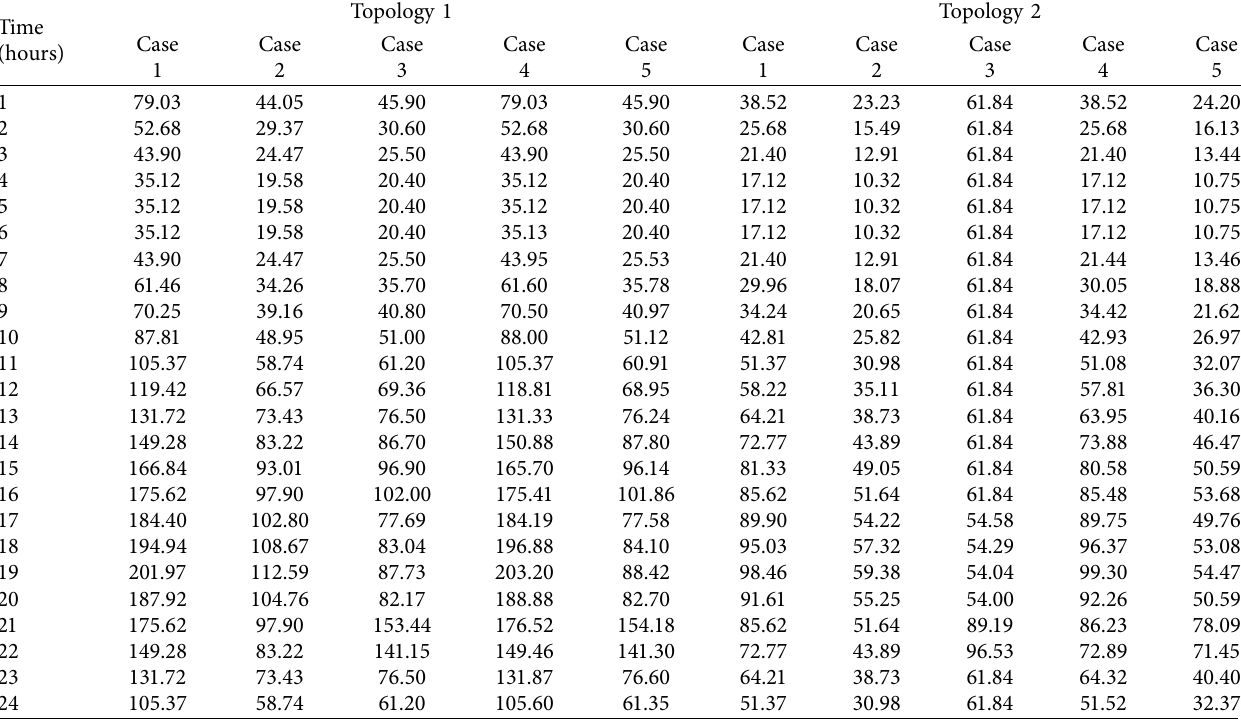
Table 7: Power loss (in kW) 33 bus system scenario